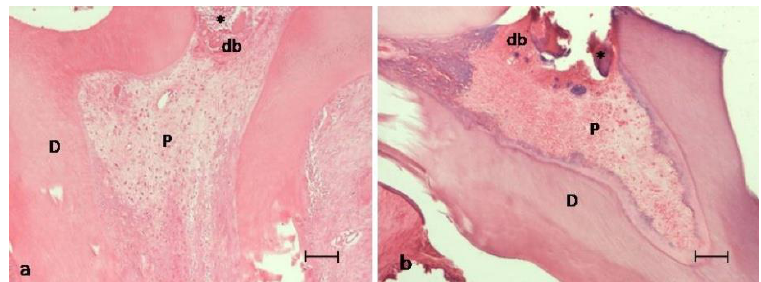
Figure 1. Images of the pulp exposure site of two experimental groups at thirty days post- treatment. ( a ) MTA group. ( b ) HA/β-TCP/C group. Both groups showed a well-developed dentinal bridge (db) formed in contact with the material (asterisk) used for pulp capping. P = viable pulp without necrosis; D = dentin. Hematoxylin and eosin staining. Scale bar: 100 micrometers.